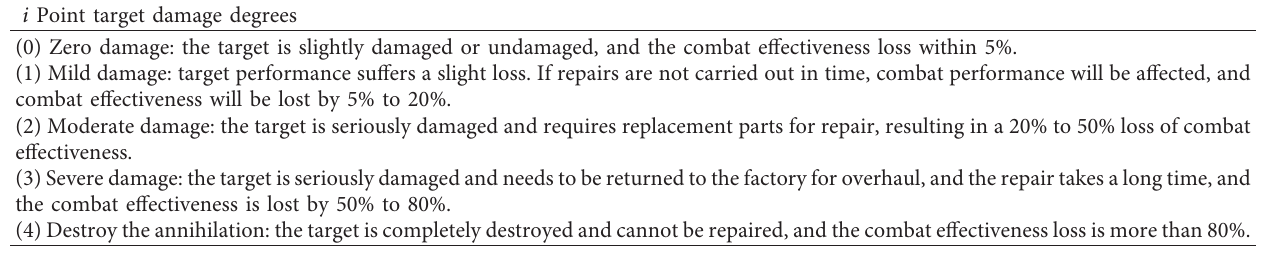
Table 1: Damage degrees classification of point